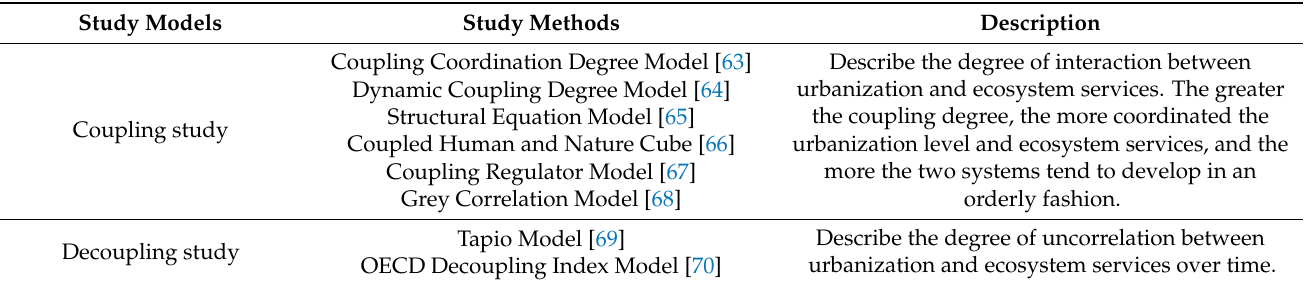
Table 1. Research